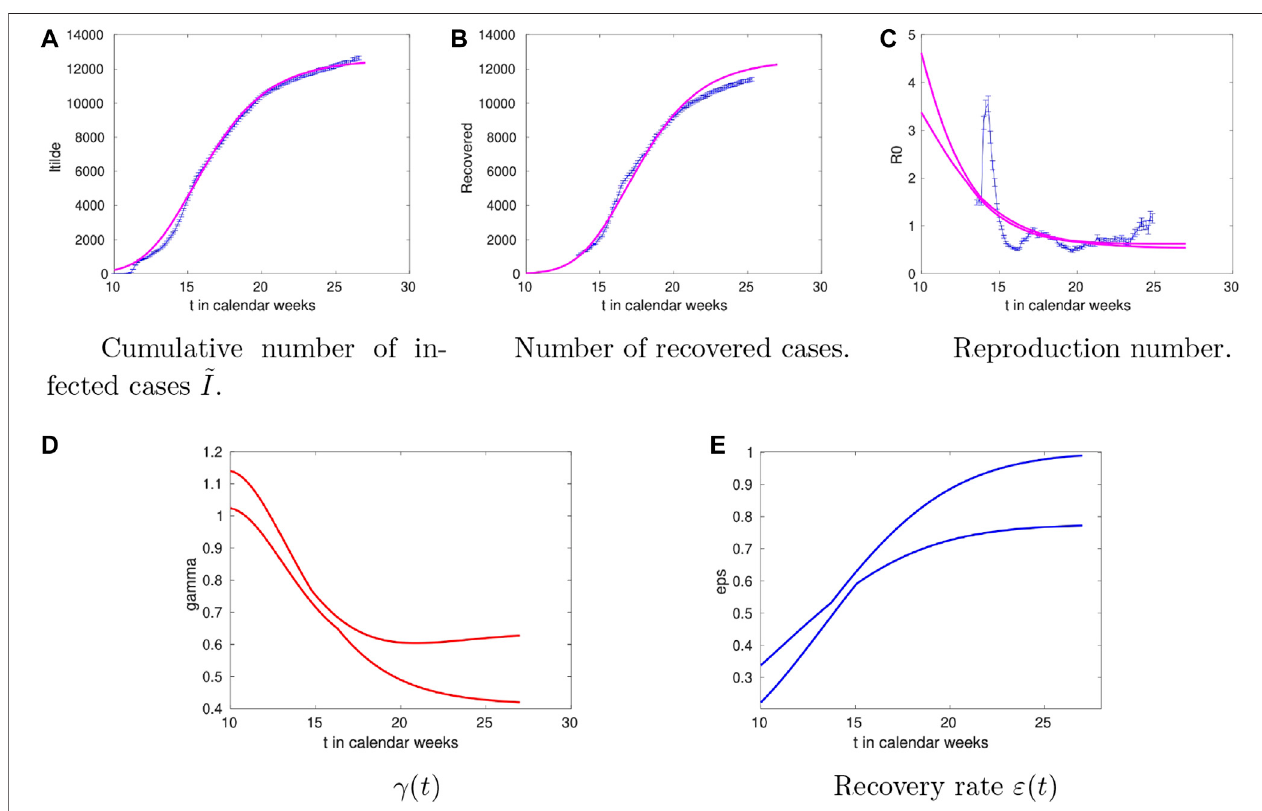
FIGURE 2 | Time dependence of ~ I ( t ) , R ( t ) , R 0 ( t ) , c ( t ) and ε ( t ) within the eRG SIR model optimised to describe the Danish data for COVID-19. Solid lines are the model (shown as a 95% con fi dence level band for the predictions) and the dots with error-bars are the data. For the chosen con fi dence intervals the errors for the fi t functions ~ I and R are not visible in this and the following fi